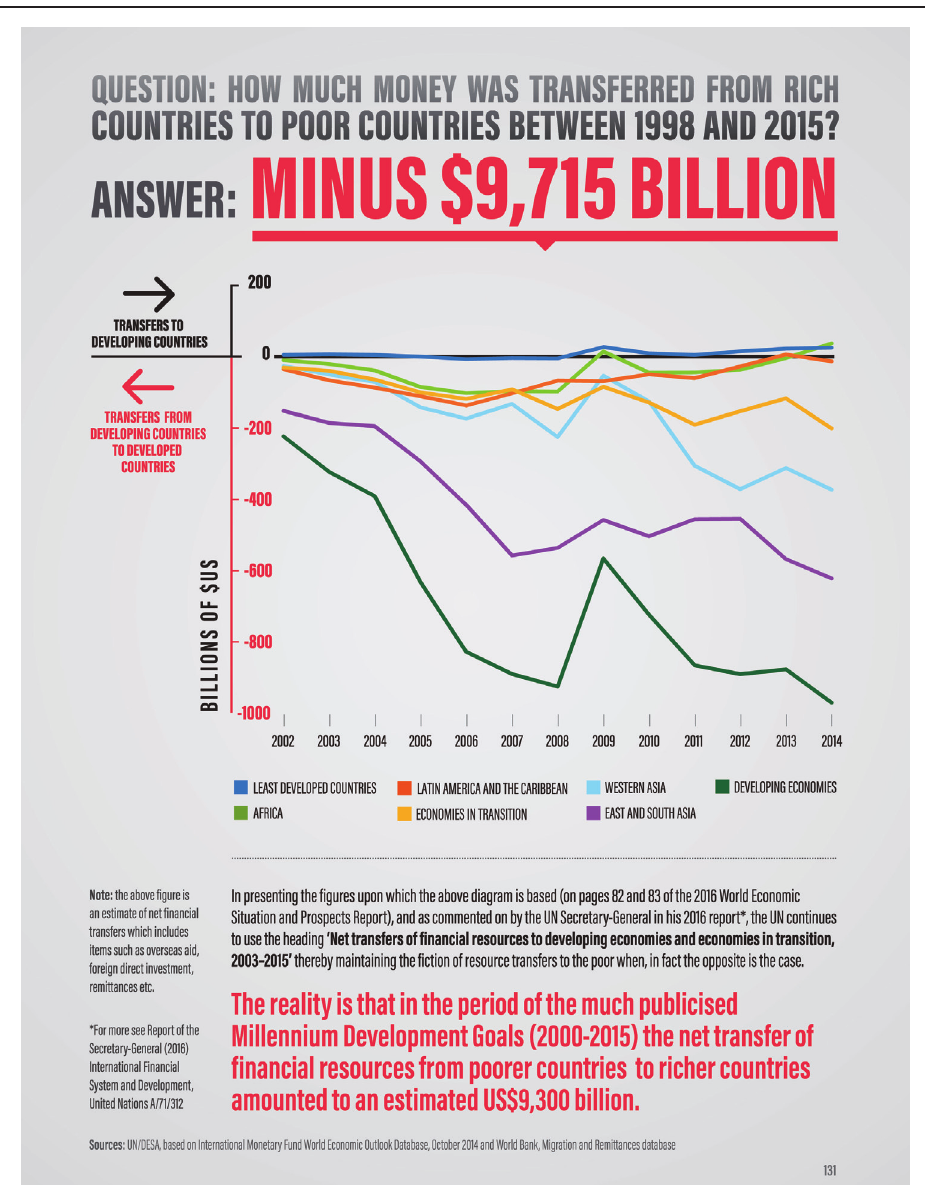
Figure 1: ‘How much money was transferred from rich countries to poor countries between 1998 and 2015?’. Reprinted with permission from Chapter 7: ‘From the rich to the poor’ by Bertrand Borg and Colm Regan